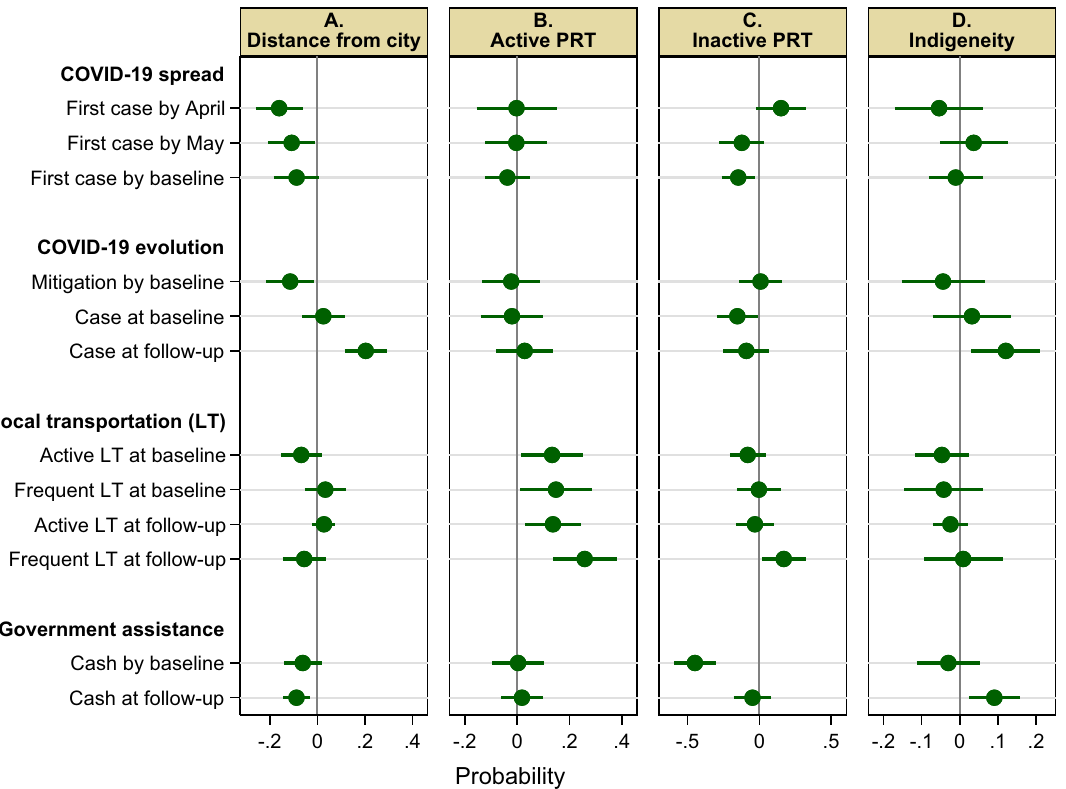
Figure 3. Remoteness, transportation, and indigeneity. The estimated impacts of distance from city (log km) ( A ), active public river transportation (PRT) (0/1) ( B ), inactive PRT (0/1) ( C ), and indigeneity (0/1) ( D ) on COVID-19 spread and evolution, local private river transportation (LT), and government cash assistance (0/1), with 95% confidence intervals based on robust standard errors. Full regression results are reported in Supplementary Tables 1 and